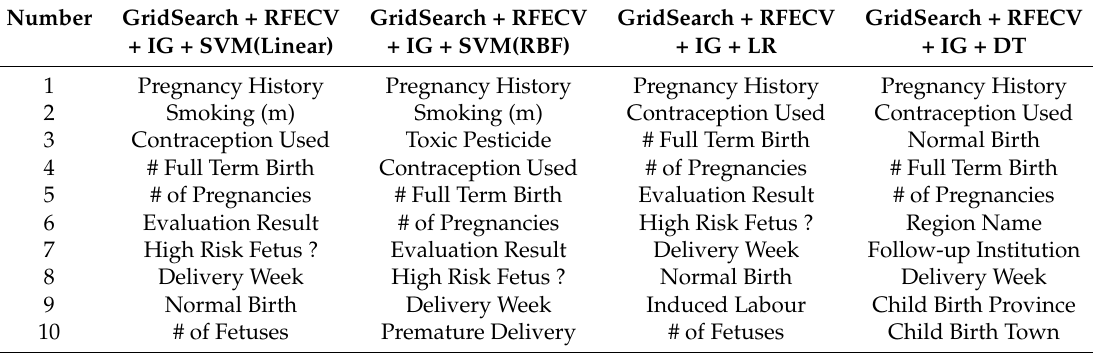
Table 6. The ranked ten principal feature subsets of GridSearch-based RFECV + IG feature selection scheme with four ML classifiers using ten-fold cross